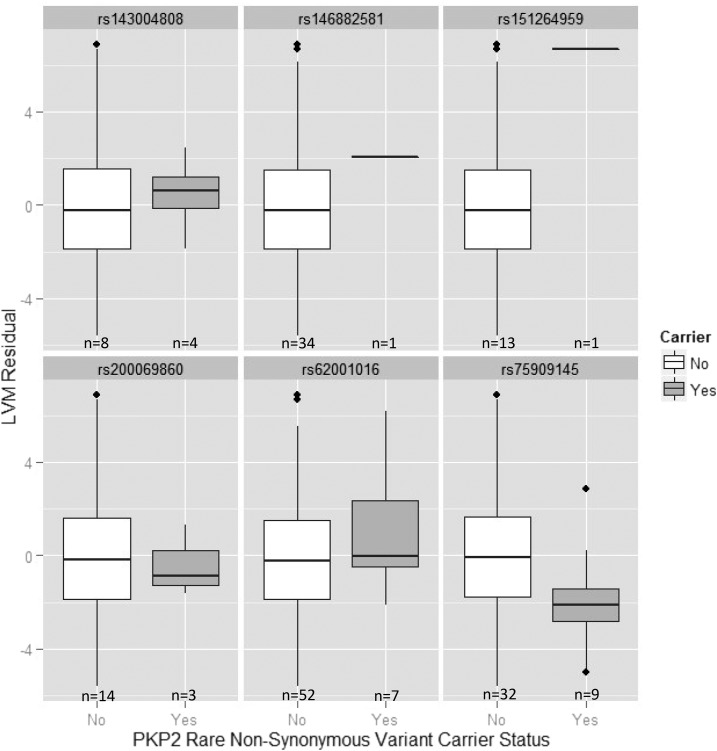
Box and whisker plots showing the distribution of LVM residual within the 10 sequenced families by PKP2 nonsynonymous rare variant carrier status, stratified by variant. LVM residuals were calculated by adjusting for sex, body mass index (BMI), systolic blood pressure, and smoking status. Carriers of a rare allele of a PKP2 variant are shown in gray and noncarriers are shown in white.